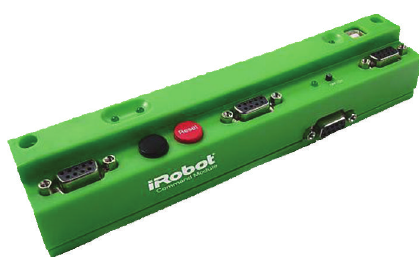
Figure 2: The iRobot command module.